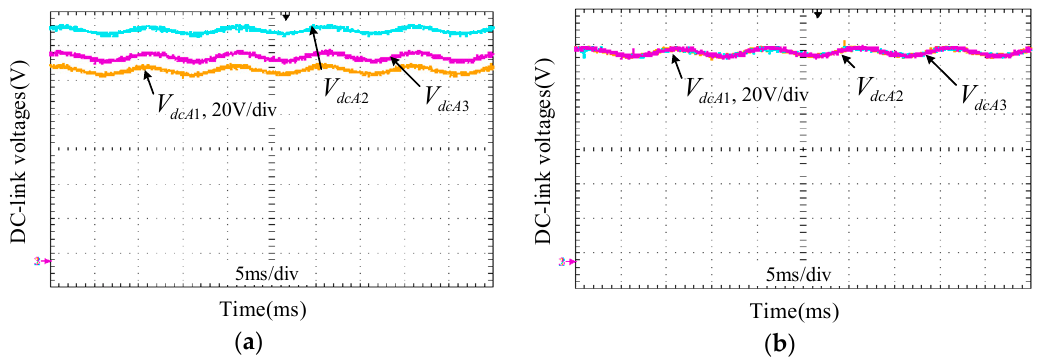
Figure 10. DC ‐ link voltages of phase A. ( a ) Without the proposed DC ‐ link voltage balancing method; ( b ) With the proposed DC ‐ link voltage balancing method.